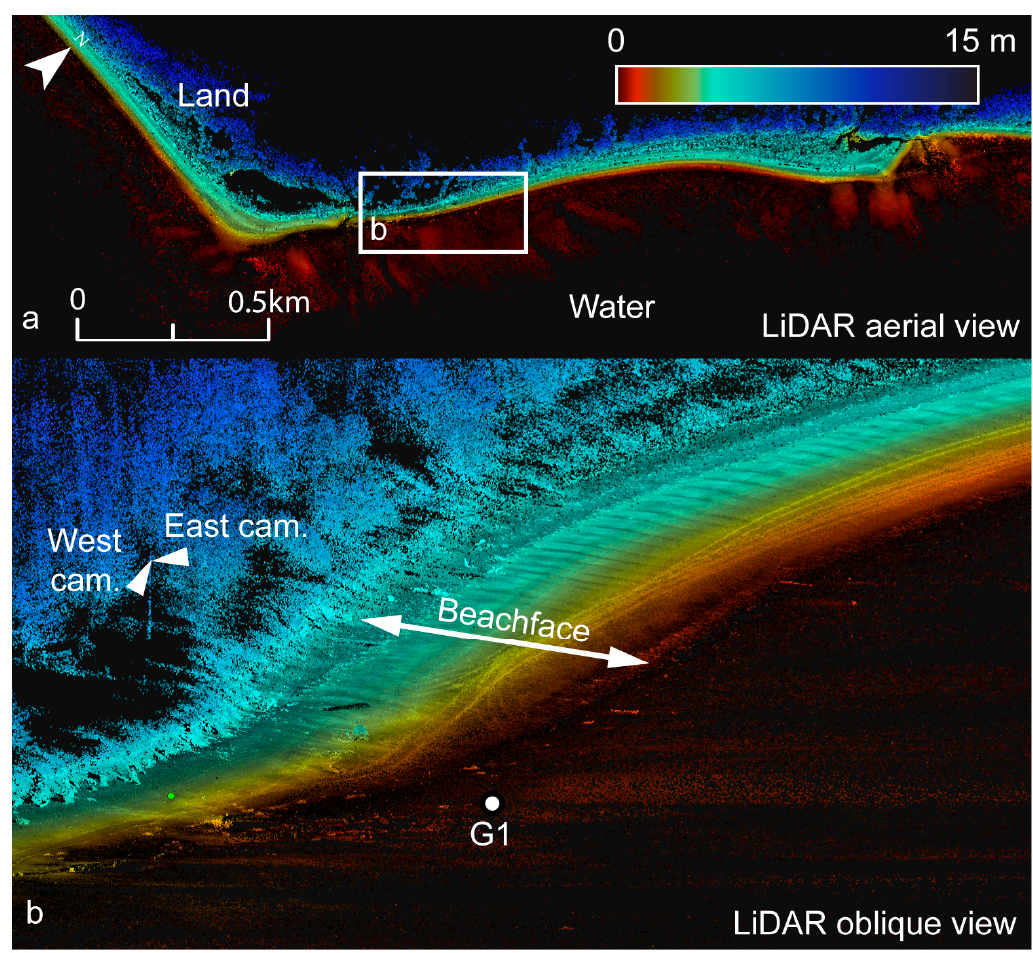
Figure 4. LiDAR point cloud from the survey of 3 August 2016 on the beach of Pointe-Lebel shown in aerial ( a ) and perspective ( b ) views.